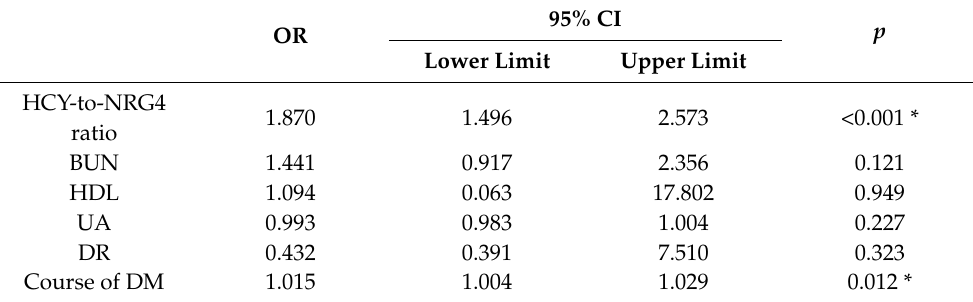
Figure 1. Comparison of NRG4, HCY and HCY/NRG4 between groups and their predictive efficacy. ( A ) Comparison of HCY among the control group, the DM group and the DKDs; ( B ) Comparison of NRG4 among the control group, the DM group and the DKDs; ( C ) Comparison of HCY/NRG4 among the control group, the DM group and the DKDs; ( D ) The predictive efficacy of NRG4, HCY and HCY/NRG4 in DKD. **** p < 0.01. Table 2. Multivariable logistic regression analyses for identifying factors independently associated with DKD